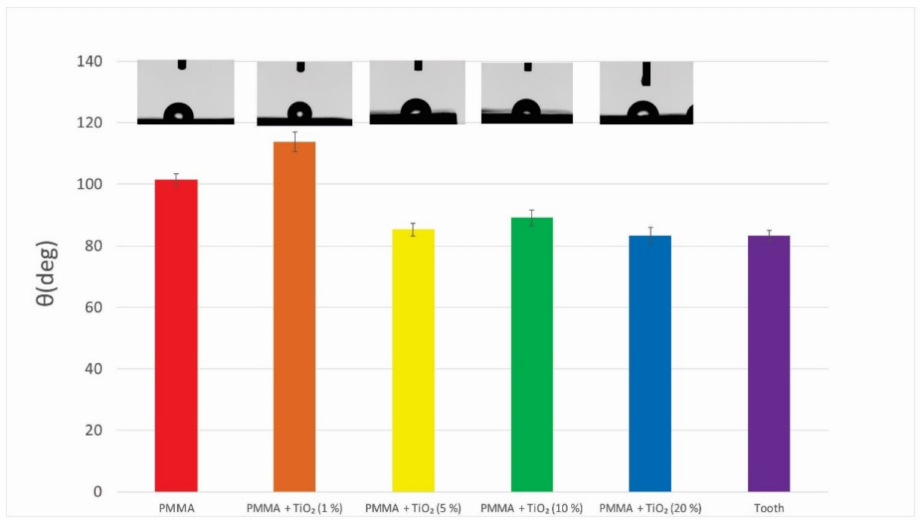
Figure 3. Contact angles of all five PMMA/TiO 2 NPs surfaces measured by the tensiometer. In inset the pictures of water droplets on the surfaces are